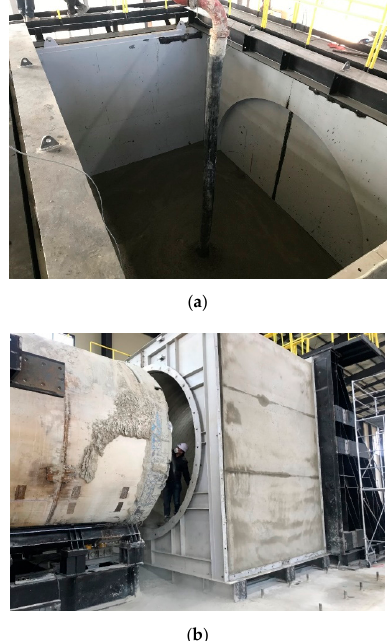
Figure 5. View of artificial rock mass and rock box at various stages, ( a ) during preparation of artificial rock mass in rock box; ( b ) view of the rock box after tests.